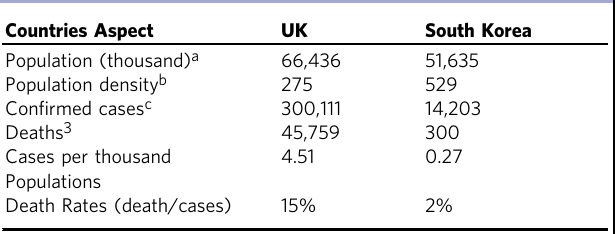
Table 3 COVID-19 con fi rmed cases and death in the UK and South